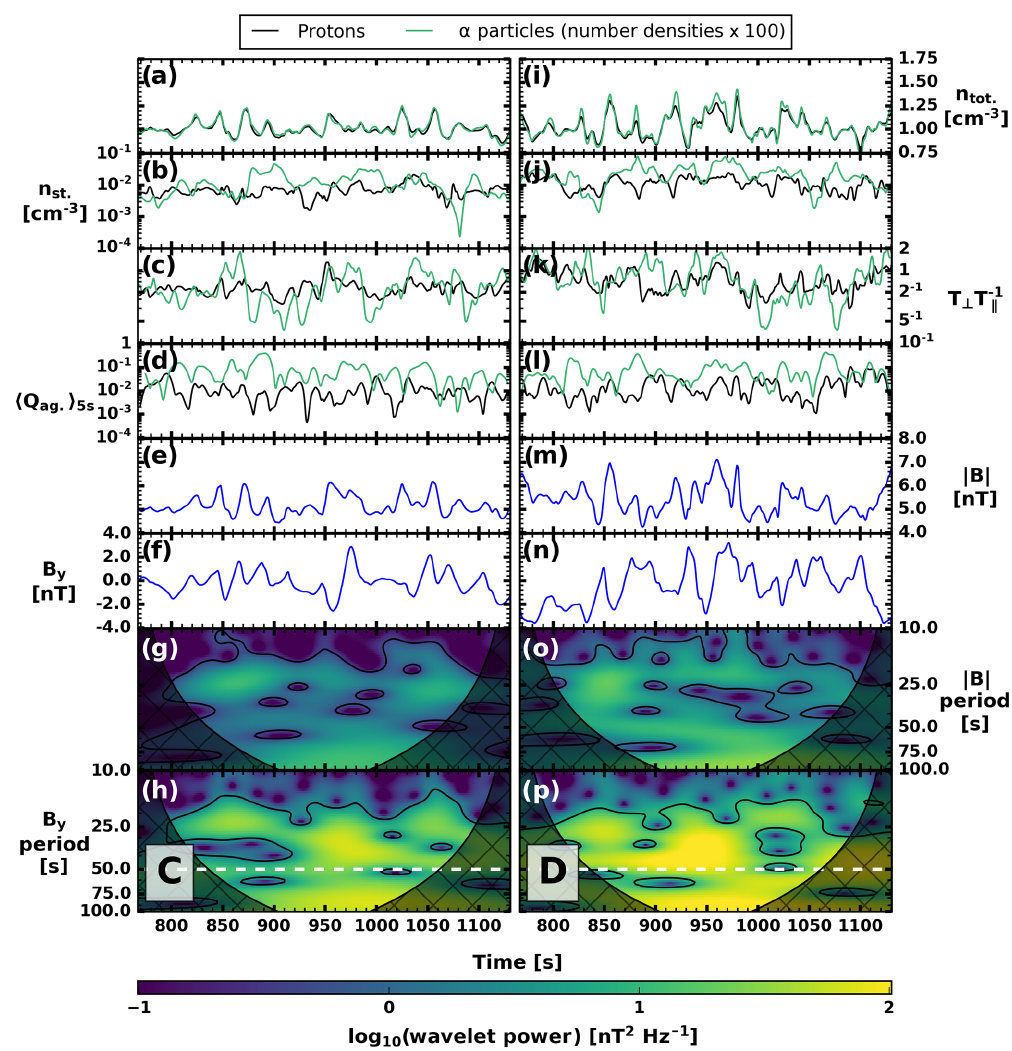
Figure 9. Time series and wavelets at virtual spacecraft positions C (a–h) and D (i–p) at the edge of the ULF foreshock. Panels (a–d) and (i–l) show proton (helium) quantities in black (green). (a, i) Total number densities. (b, j) Suprathermal number densities on a logarithmic scale. (a, b, i, and j) The helium number densities have been multiplied by 100. (c, k) Temperature anisotropies. (d, l) Agyrotropy Q ag measured as a 5s running average. (e, m) Magnetic field magnitudes | B | . (f, n) Magnetic field out-of-plane components B y . (g, o) Wavelet power spectra of | B | fluctuations. (h, p) Wavelet power spectra of B y fluctuations. The black contours show the 95% confidence level, and the cross-hatched regions denote the cone of influence. The white dashed lines show the expected frequency of B y fluctuations (see